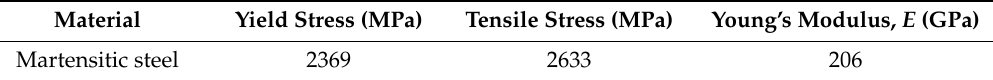
Figure 2. Stress vs. strain curve of the martensitic steel. Table 2. Mechanical properties of the martensitic steel.